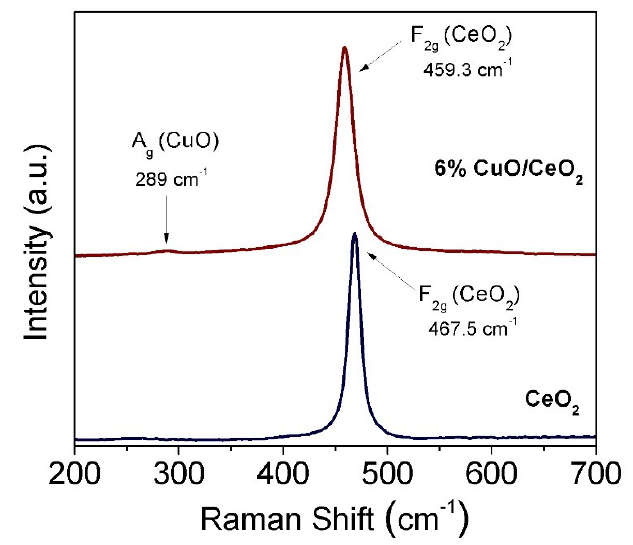
Figure 4. Raman spectra of CeO 2 and 6% CuO-CeO 2 prepared by combustion synthesis in the spectral region of 200–700 cm − 1 , showing both the F 2g mode of CeO 2 and the A g mode of CuO in case of the 6% CuO-CeO 2 catalyst.